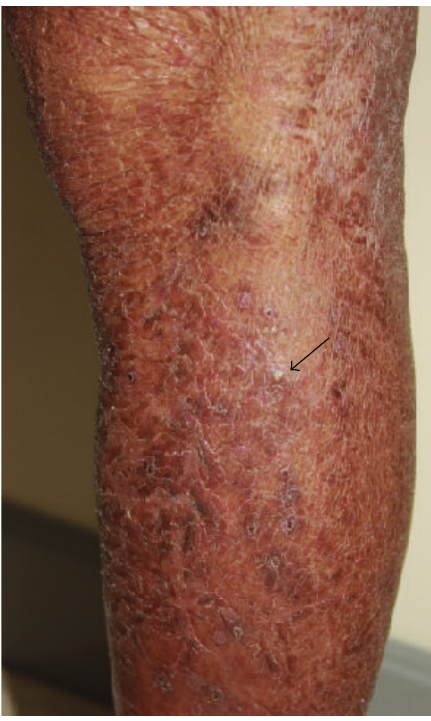
Figure 2: Xerosis. Ill-defined dried scaly patch with mild erythema on the left leg, occurring 3 weeks following gefitinib. Notice scattered pustules, showing evidence that xerosis took place where papulopustules have developed.